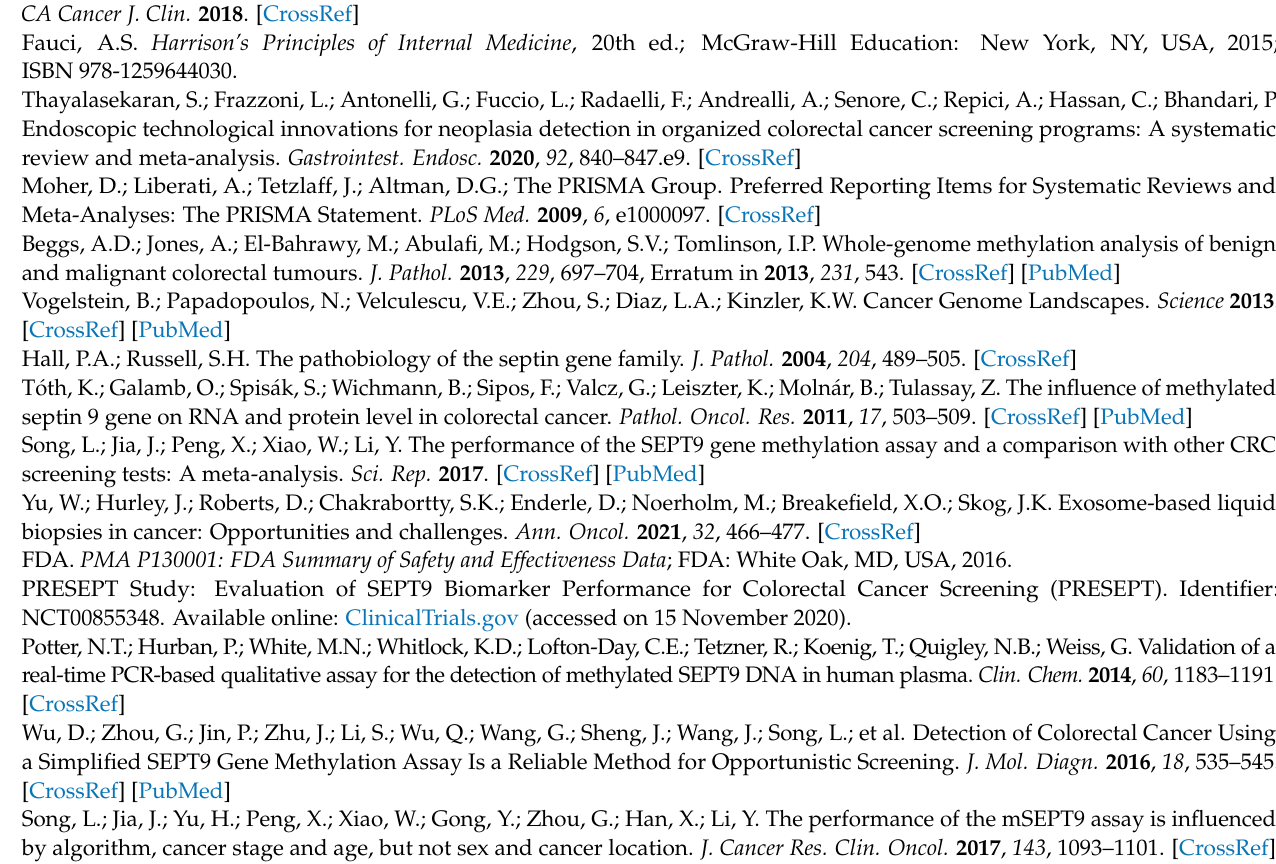
Supplementary Materials: The following are available online at https://www.mdpi.com/article/10.3 Table S2: Summary of methylated genes panels feasible for CRC detection, Table S3: miRNAs as CRC biomarkers, Table S4: piRNAs as CRC biomarkers, Table S5: t-M2-PK as CRC screening tool, Table S6: Gut microbiota as CRC screening tool, Table S7: Stool volatile organic compounds (VOCs) based CRC